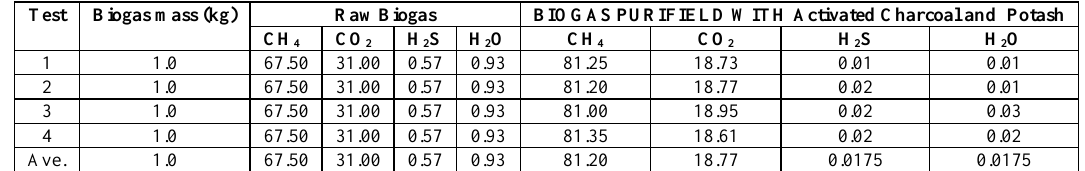
Table 4. Purification results of testing with activated charcoal and